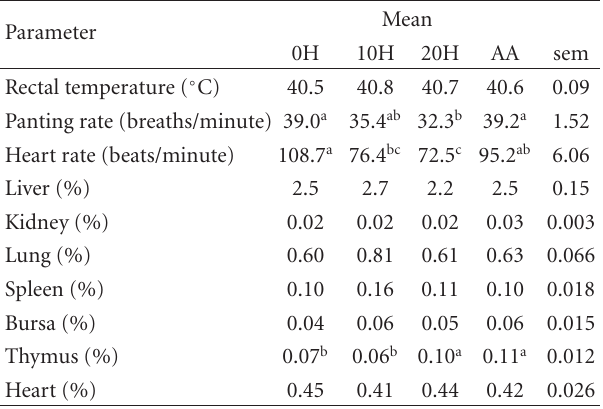
Table 5: E ff ect of honey on physiological responses and relative weight of organs of broiler chickens during hot-dry